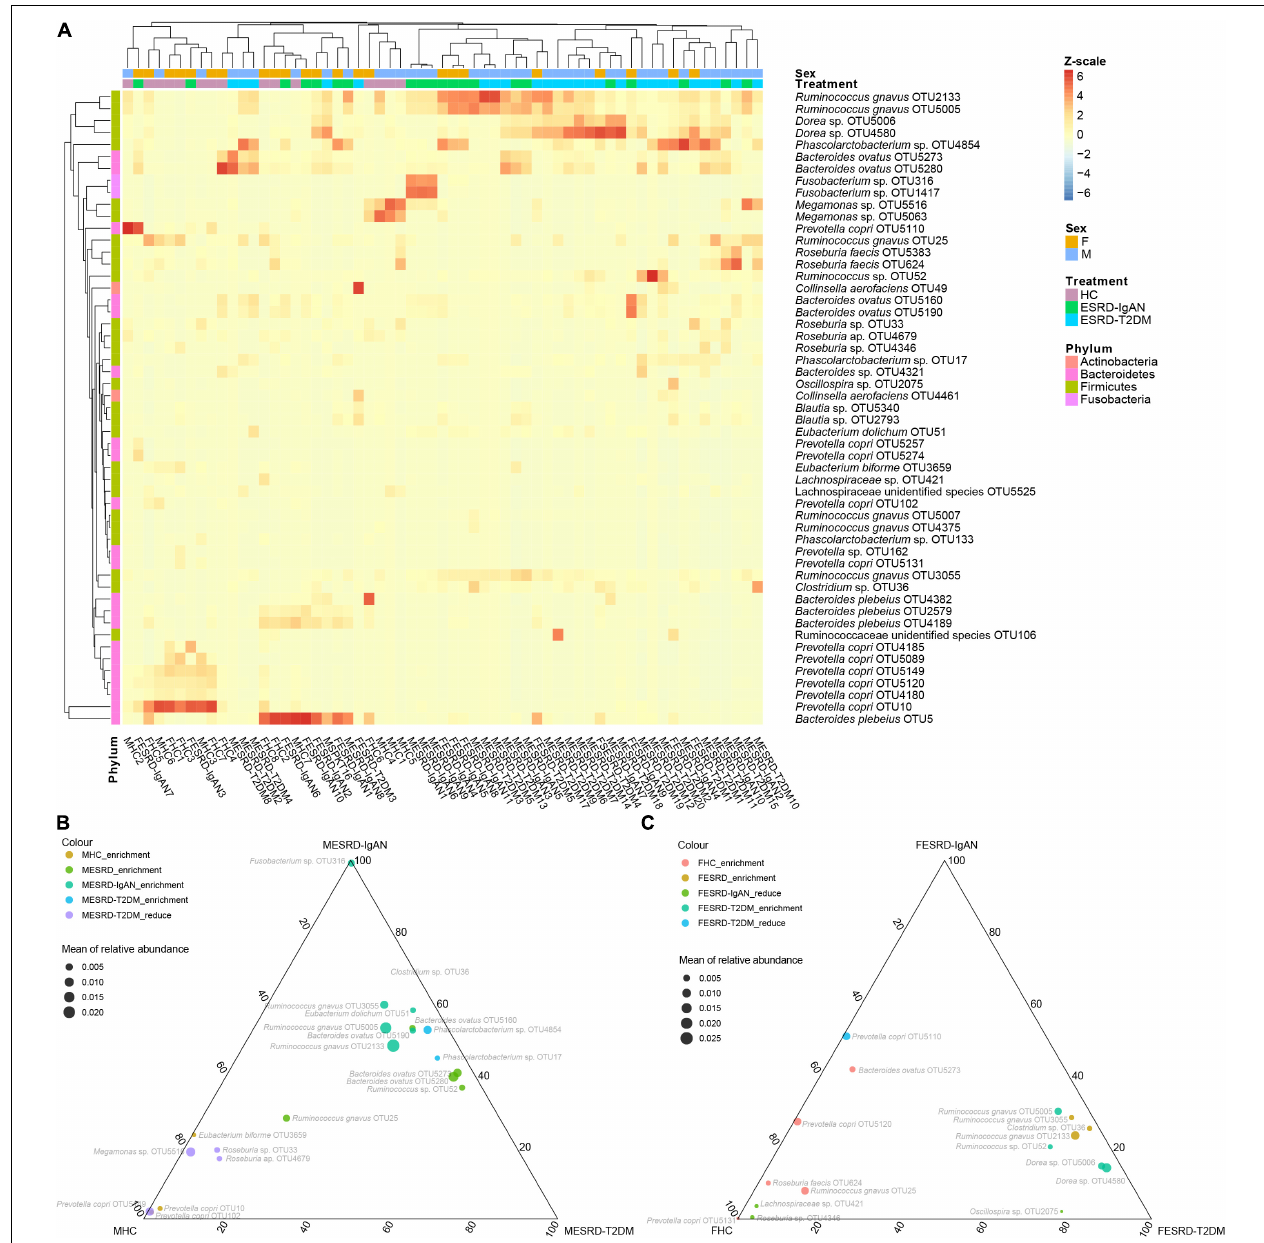
FIGURE 3 | (A) Heatmap and (B,C) ternary diagram profiles showing the dominant OTU differences in fecal microbiota of male and female healthy controls and patients with end-stage renal disease caused by IgA nephropathy (ESRD-IgAN) or type-2 diabetes mellitus (ESRD-T2DM). FHC, FESRD-IgAN, and FESRD-T2DM indicate female healthy control and patients with end-stage renal disease caused by IgA nephropathy (ESRD-IgAN) or type-2 diabetes mellitus (ESRD-T2DM), respectively. MHC, MESRD-IgAN, and MESRD-T2DM indicate male healthy control and patients with ESRD-IgAN, or ESRD-T2DM,